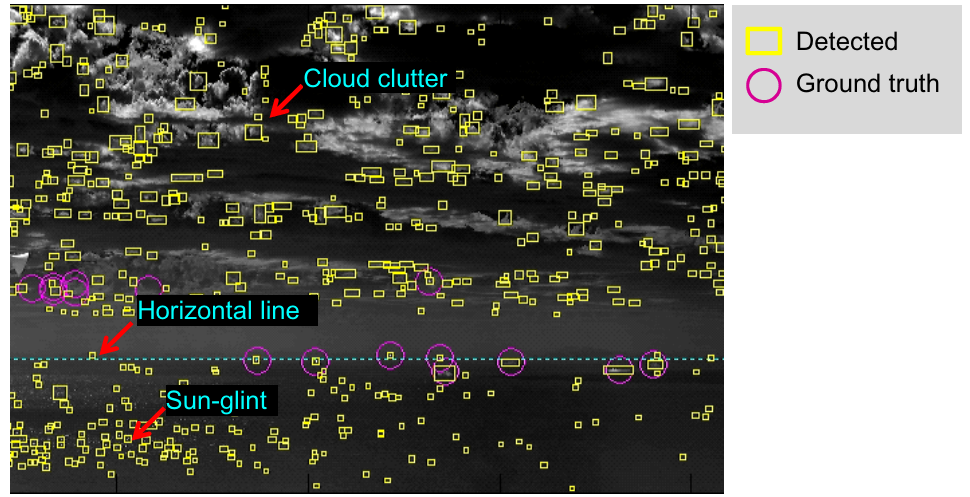
Detected Ground truthCloud clutter